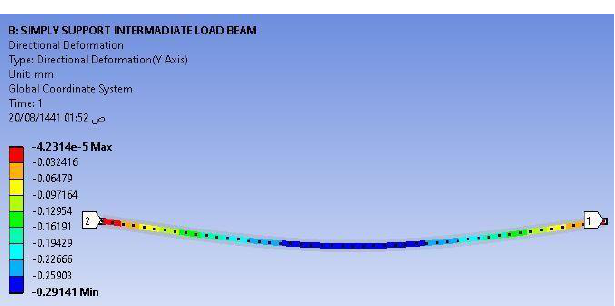
Fig. 11. Direction deformation (-4.2314e -5 mm Max) of cemented carbide, simply supported beam under centre or midpoint load of 1000N